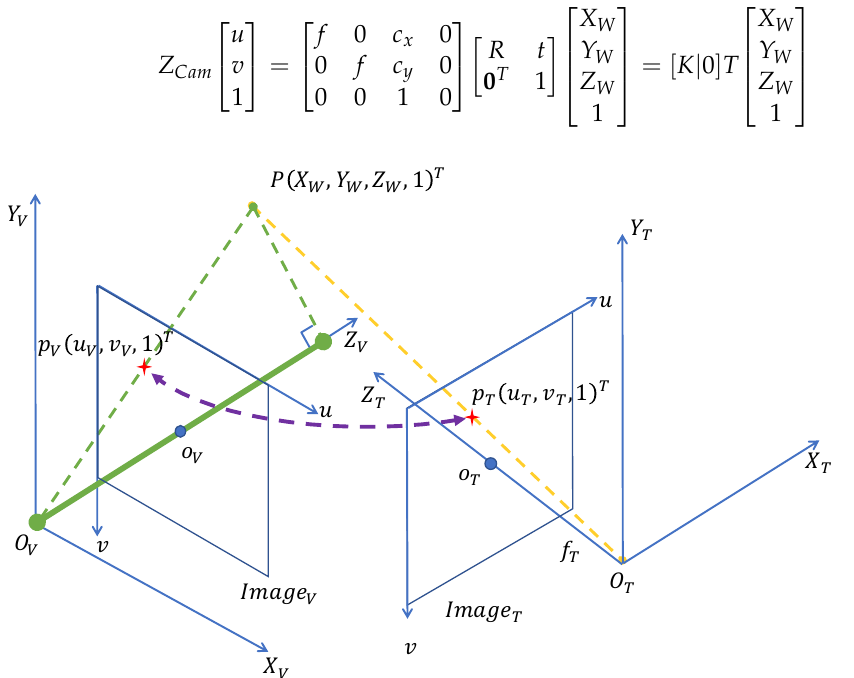
Figure 9. We find the 3D point corresponding to the 2D points in the visible image by depth. Depth refers to the distance from the optical center O V to the projection of point P on the z-axis (camera coordinate system of visible image), as shown by the solid green line. The corresponding point on thermal image is then found by projecting this 3D point onto it. In this way, we can establish a pixel-wise correspondence from visible to